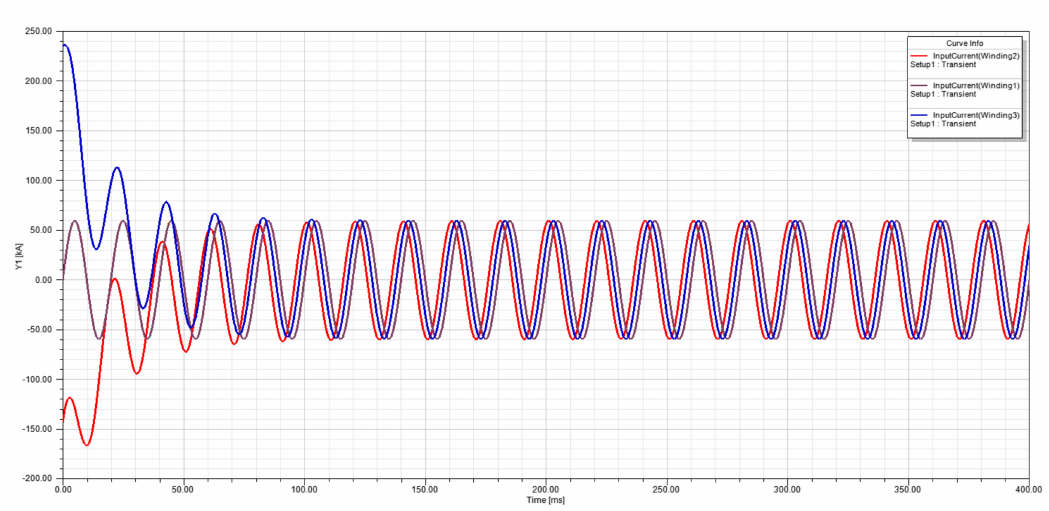
Figure 10. Short-circuit current characteristics that were implemented for simulation analyses.